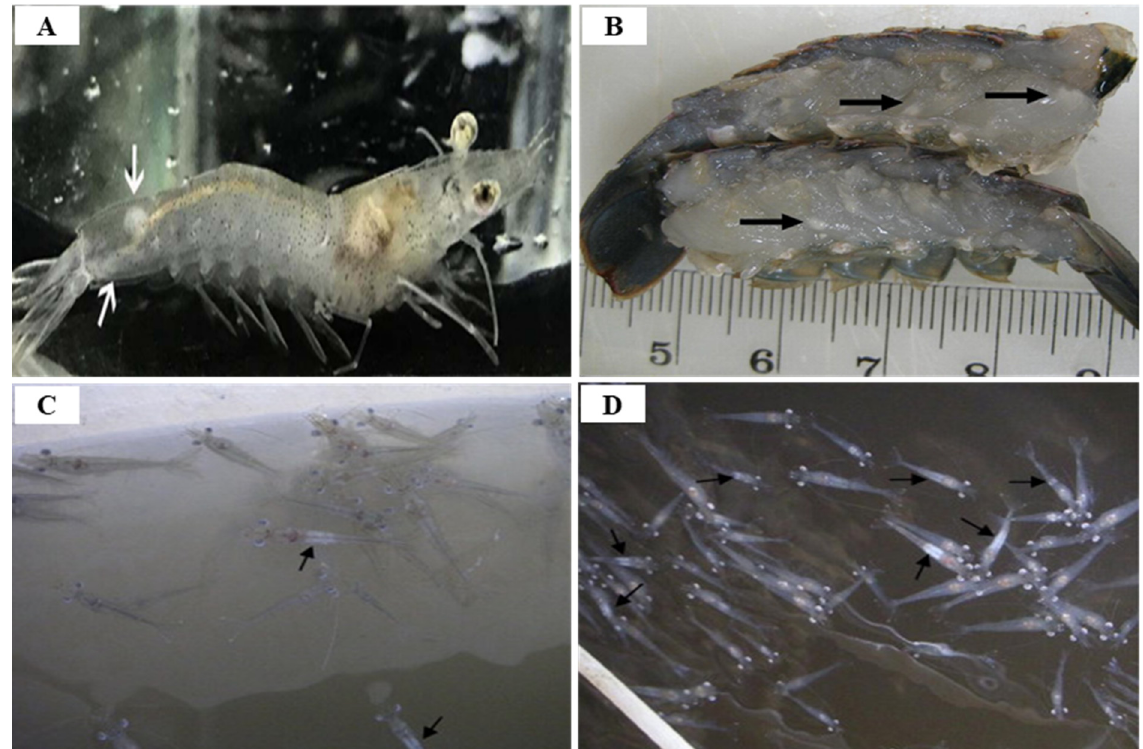
Figure 22. External symptoms of shrimps with White tail disease (WTD). ( A ) Mr NV-infected Penaeus vannamei showing signs of whitish muscle in the tail (arrows); ( B ) Cherax quadricarinatus showing signs of WTD with necrosis and myositis (arrows); ( C , D ) Clinical signs, whitish abdominal muscles (arrows), in the infected post-larvae of Penaeus indicus ((A) Reprinted from Aquaculture, Vol. 483, Jariyapong, P., Pudgerd, A., Weerachatyanukul, W., Hirono, I., Senapin, S., Dhar, A.K., Chotwiwatthanakun, C., Construction of an infectious Macrobrachium rosenbergii nodavirus from cDNA clones in Sf9 cells and improved recovery of viral RNA with AZT treatment, p. 9, Copyright (2018), with permission from Elsevier; ( B ) Reprinted from Aquaculture, Vol. 319 (1 – 2), Hayakijkosol,